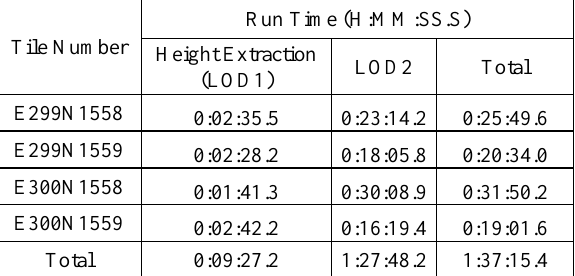
Table 8. Overall Processing Time (Test Bench